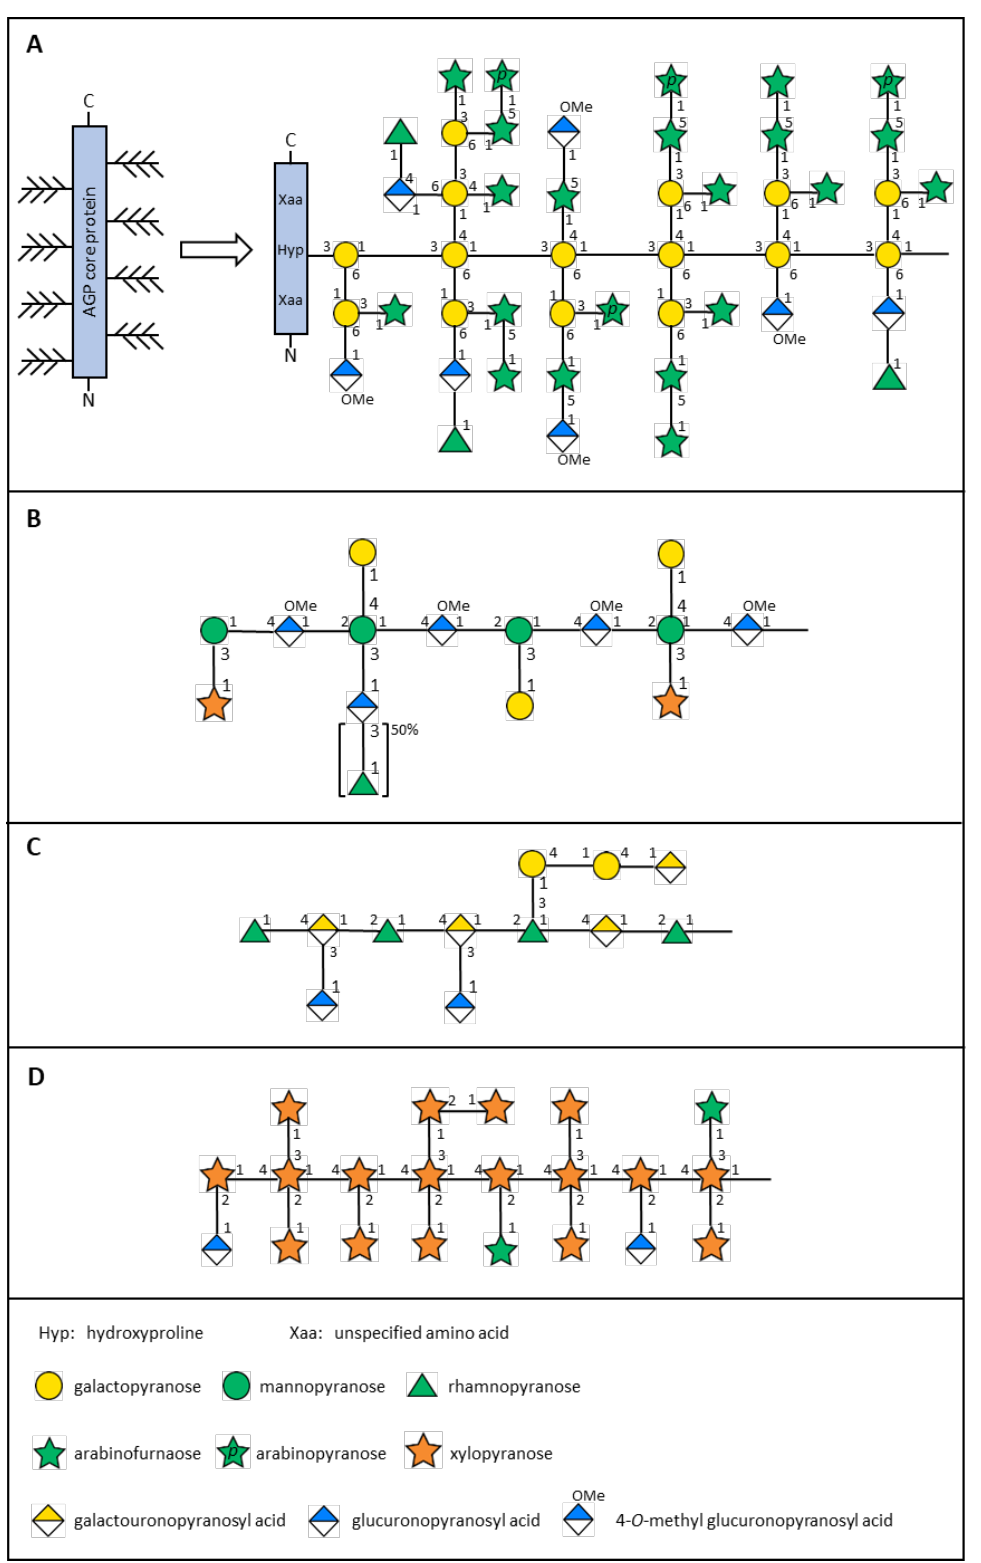
Figure 1. Schematic representations of possible structures for ( A ) puka gum, ( B ) mamaku Figure1. Schematicrepresentationsofpossiblestructuresfor( A )pukagum, ( B )mamakupolysaccharide, polysaccharide, ( C ) houhere mucilage, and ( D ) harakeke mucilage. ( C ) houhere mucilage, and ( D ) harakeke